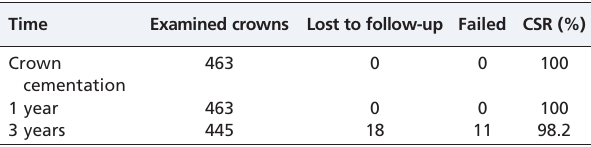
Table 2 - Crowns lost to follow-up and the cumulative survival rate